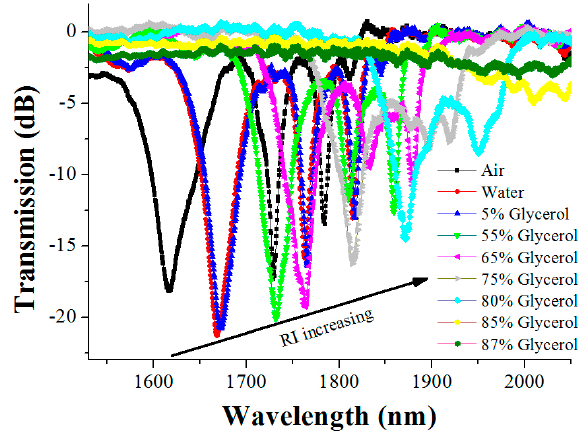
Figure 3. The transmission spectra of the LPFG in different environment media over the wavelength range from 1530 nm to 2050 nm.